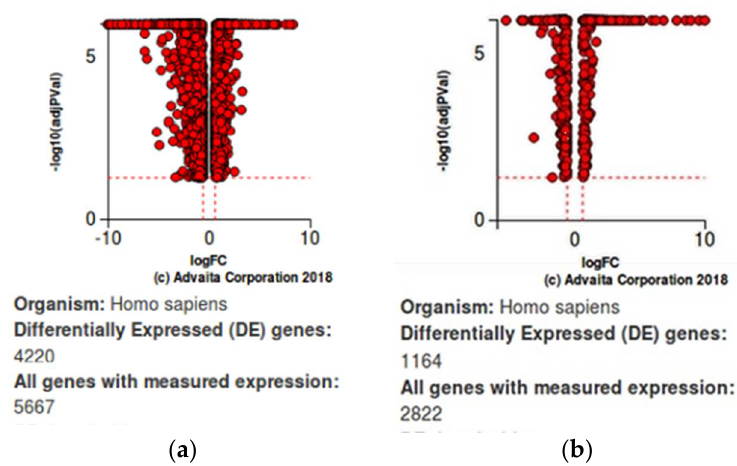
Figure 4. Volcano plots: ( a ) For 24 h of JQ1 treatment. DE thresholds: Fold change 0.6, p -value 0.05.; ( b ) For four hours of Dex treatment. x-axis: log fold change (log FC), y-axis: negative logarithm of adjusted p -value -log10 (adjPVal). DE thresholds: Fold change 0.6, p -value 0.05.